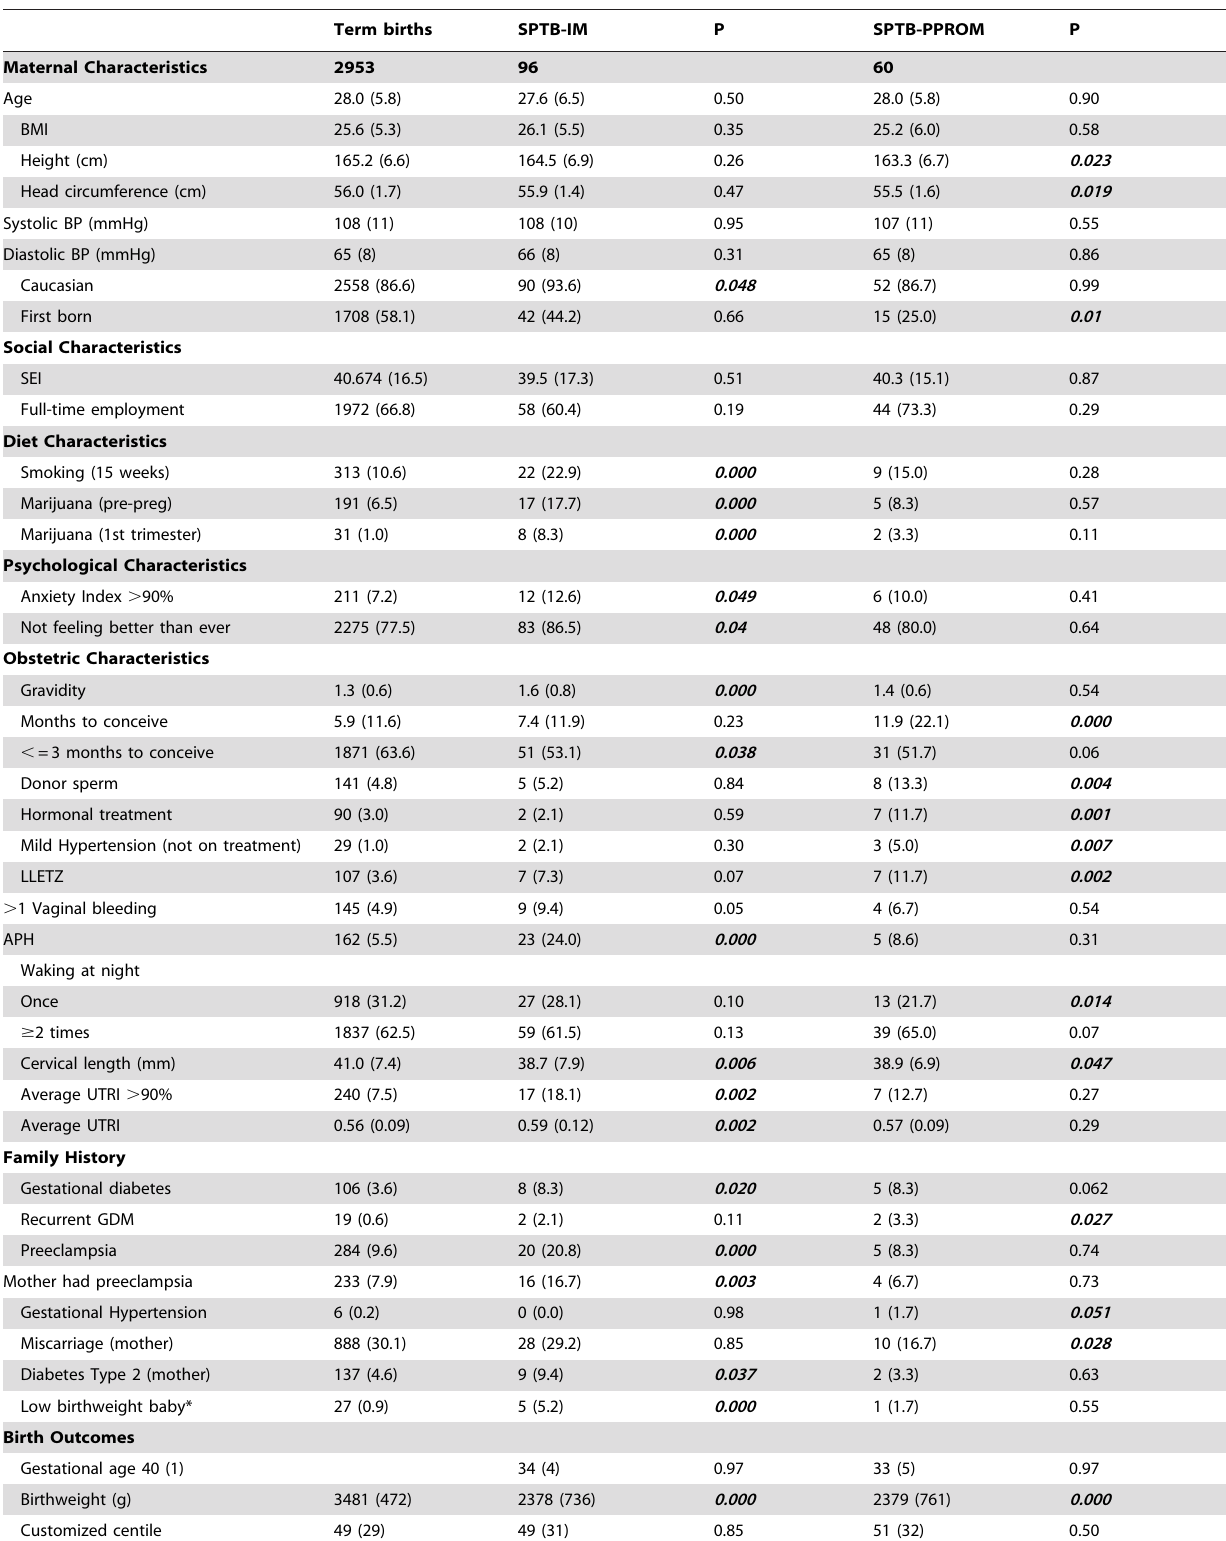
Table 1. Clinical